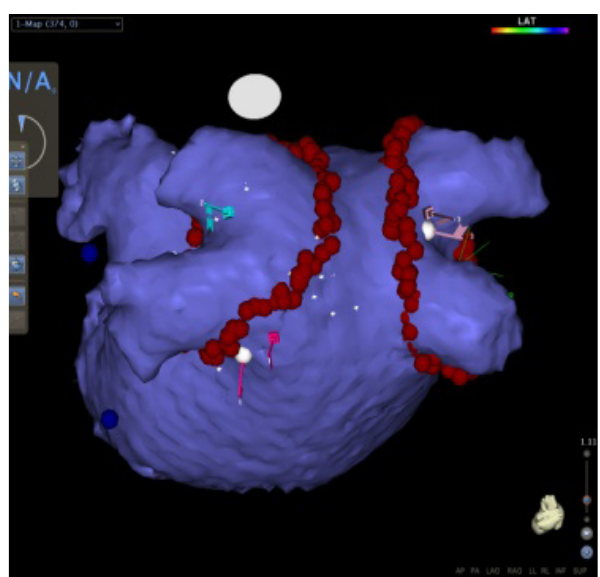
Fig. 1. CARTO3 left atrium3D